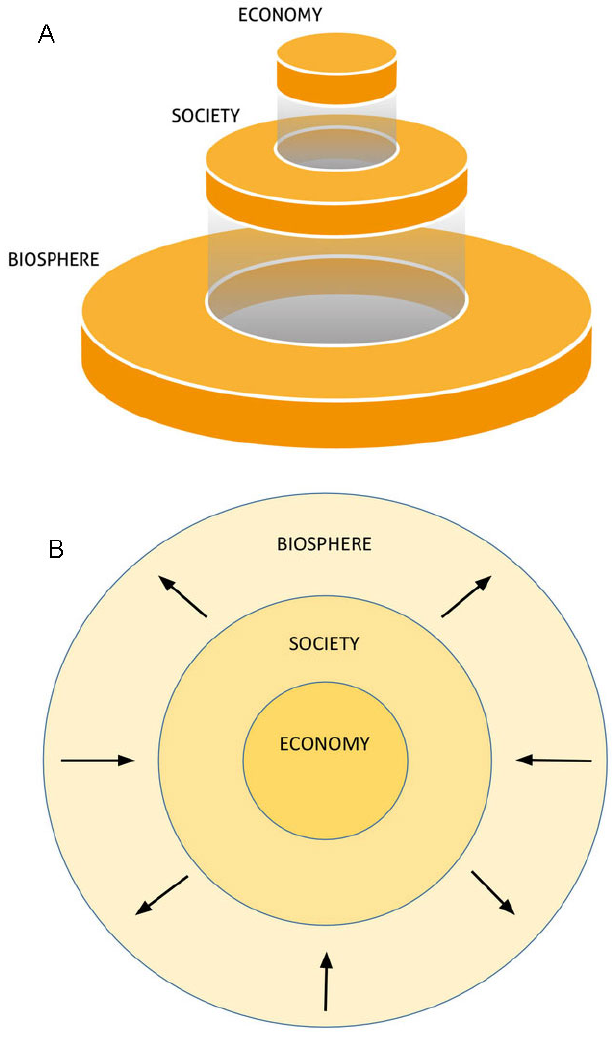
Fig. 3 . The economy and society as embedded within the biosphere, as intertwined parts of the planet. The biosphere serves as the foundation upon which prosperity and development ultimately rest. (A) based on C. Folke’s lecture notes of early 1990s, (B) inspired by, e.g., Boulding (1966), Odum (1989), and Daly (1991), see also Folke (1991), Perrings et al.